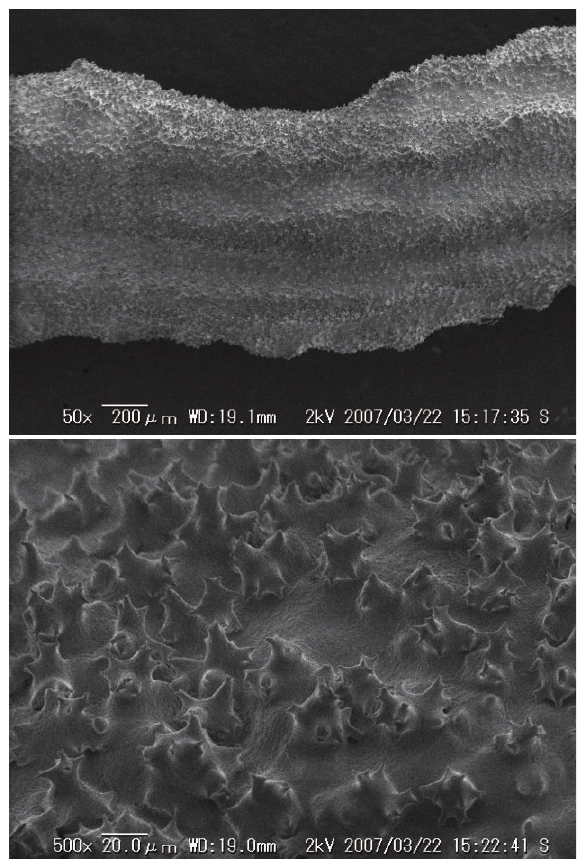
Figure 20: SEM image of axis surface of Corallium elatius ; OCA-